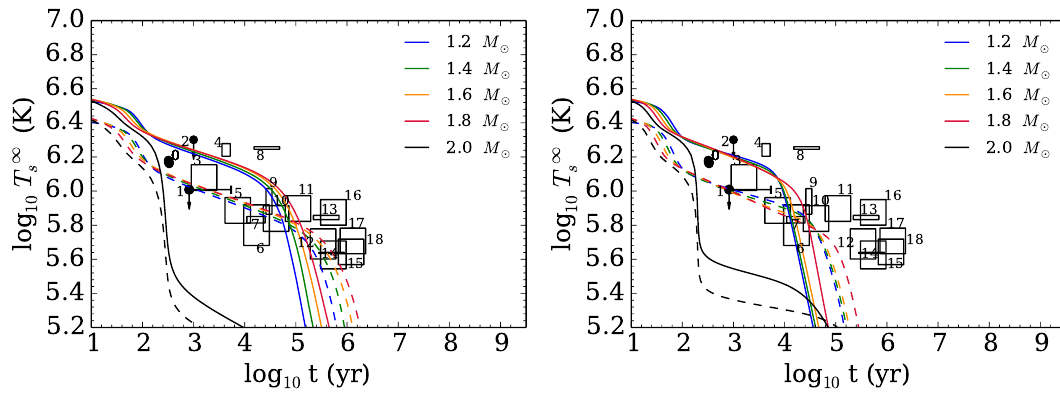
Figure 6. The same as lower panel of Figure 4, but supplemented with the triplet neutron pairing in the core of the star described by the T72 model [52] (left panel) and the AO model [54] (right panel).